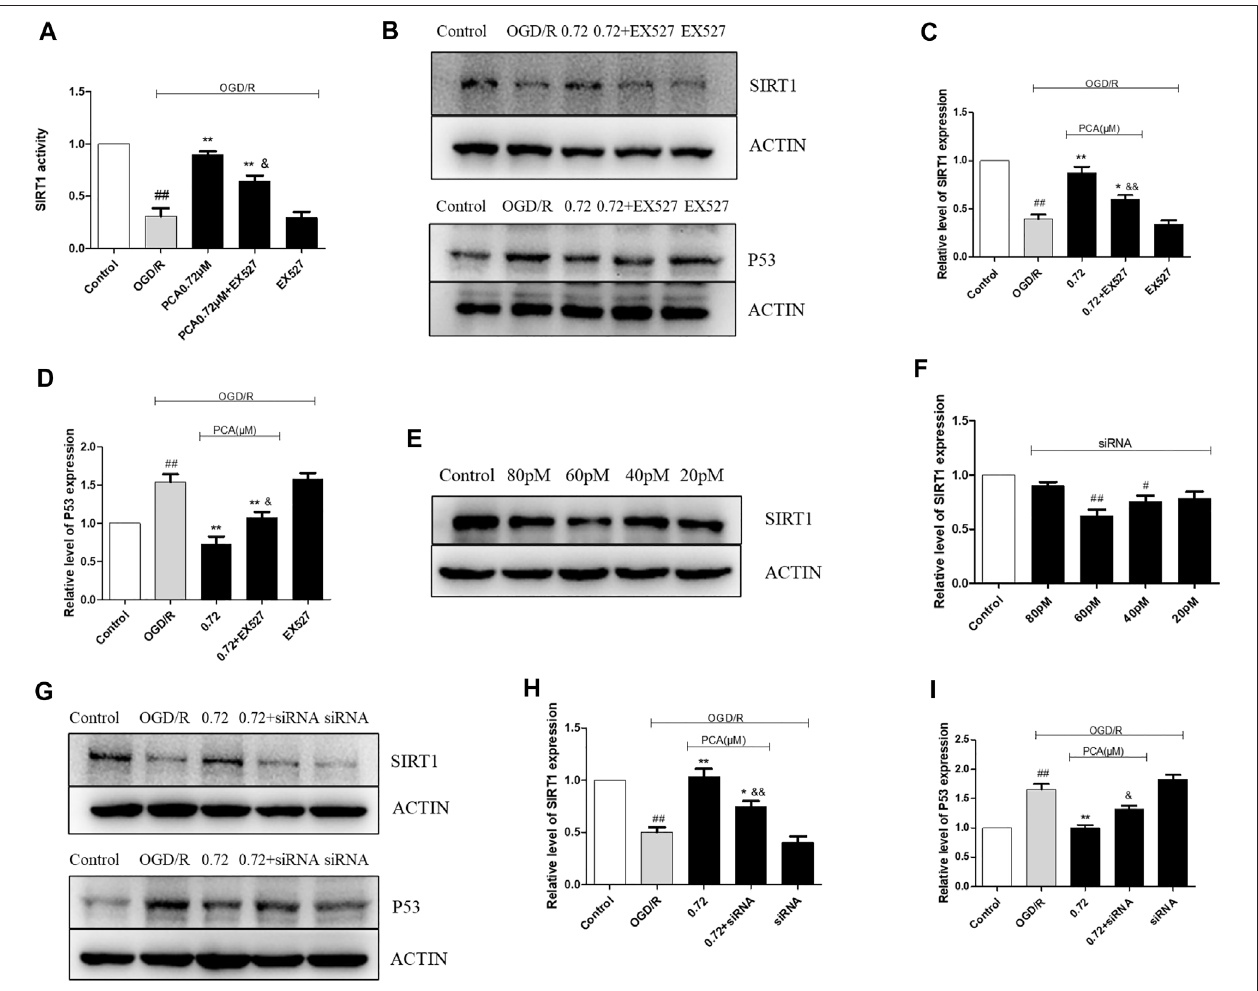
FIGURE 7 | The effect ofEX527 and SIRT1 siRNA on SIRT1 and P53. (A) The effect of EX527 on SIRT1 activity after OGD/R-induced injury. (B – D) Representative images of WB analysis and the semi-quanti fi cation of SIRT1, P53 in HUVECs. (E, F) Expression levels of SIRT1 proteins under different concentrations of SIRT1 siRNA (20 – 80 p.m.). (G – I) Representative images of WB analysis and the semi-quanti fi cation of SIRT1, P53 in HUVECs. The values are expressed as the mean ± SD ( n = 3). ## p < 0.01, # p < 0.05 vs. Control, ** p < 0.01, * p < 0.05 vs. OGD/R, && p < 0.01, & p < 0.05 vs. PCA 0.72 μ